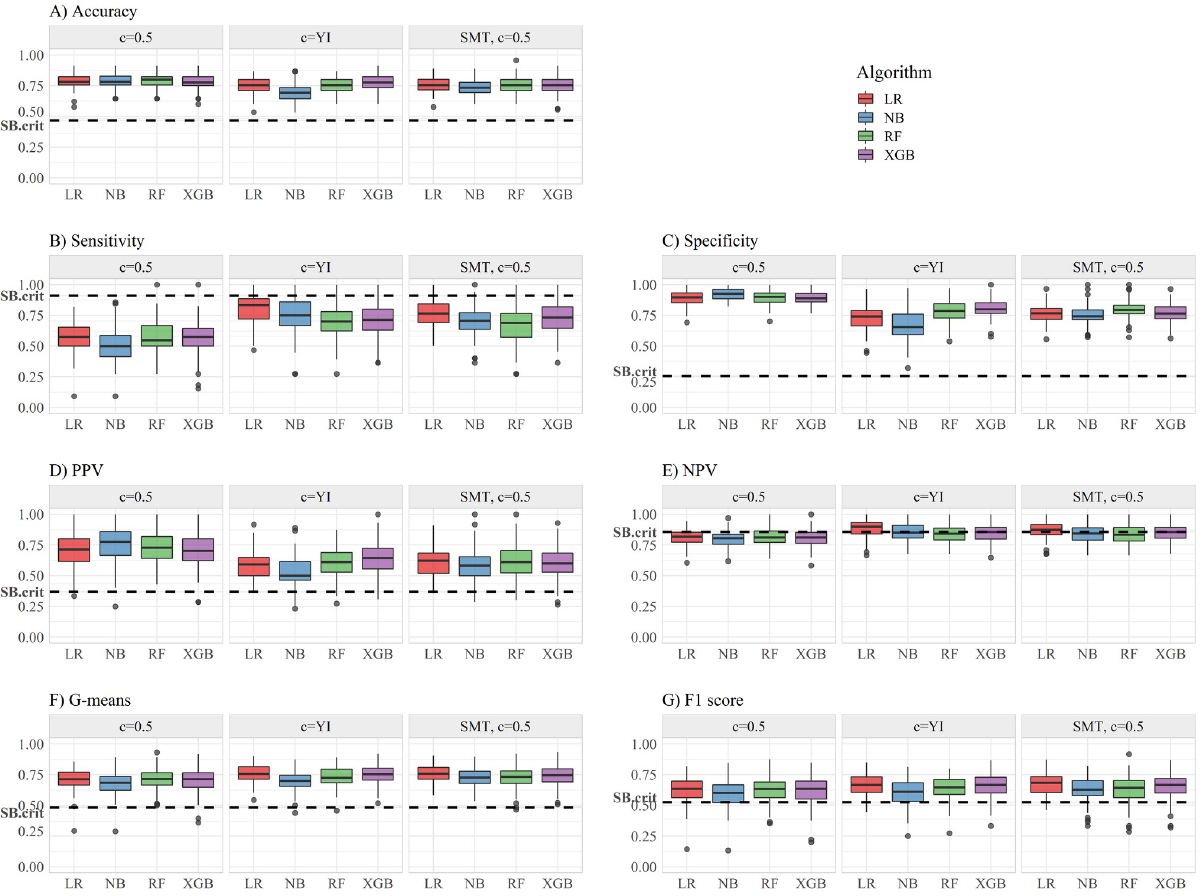
Fig 2. Comparison of operating characteristics values between different classification algorithms, and strategies to deal with data imbalance. The dashed line represents the value obtained when applying SB criteria. Acc : accuracy; Sens : sensitivity; Spec : specificity; PPV : positive predictive value; NPV : negative predictive value; SMT: synthetic minority oversampling technique; YI: Youden Index; LR: logistic regression; NB: naive Bayes; RF: random forest; XGB: extreme gradient boosting; SB: Simon Broome criteria.